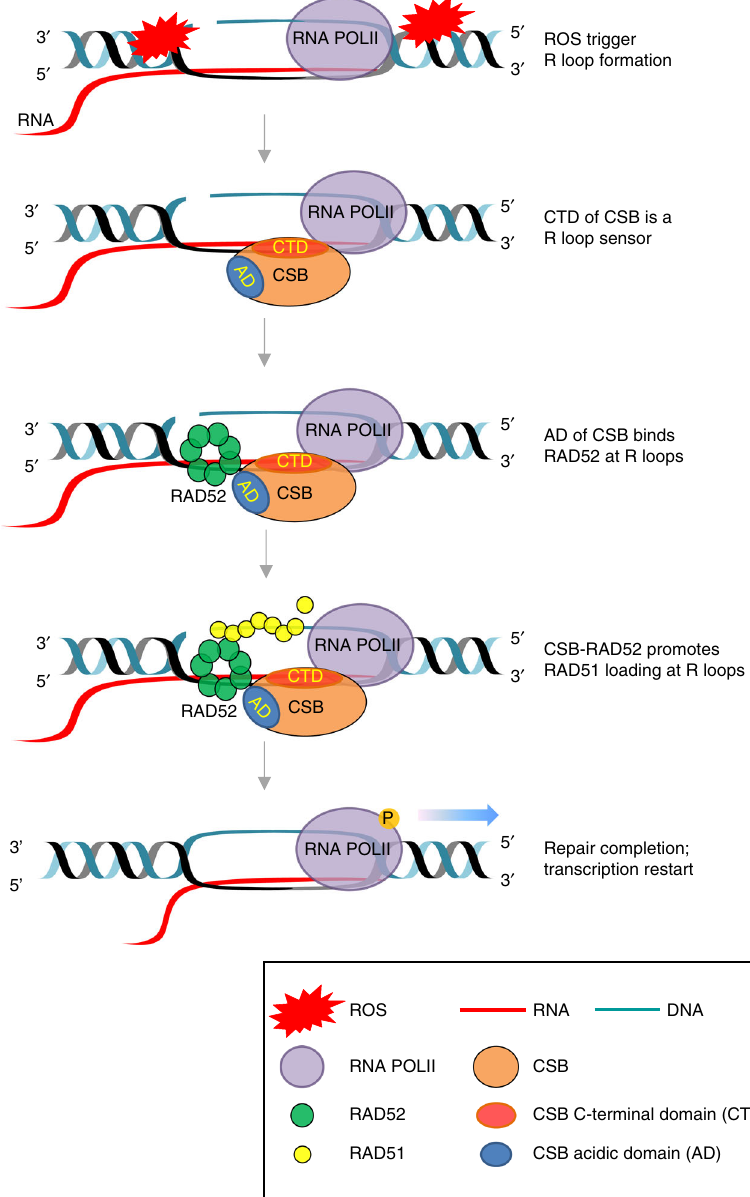
Fig. 6 Model of CSB-, RAD52-, and RAD51-mediated TC-HR at ROS-induced R loops in transcribed regions. The current model is composed of the following sequential steps: ROS at transcribed regions trigger R loop formation; CSB senses R loops via its CTD; AD of CSB binds RAD52 and facilitates RAD52 recruitment at R loops; CSB-RAD52 promotes RAD51 loading at R loops; repair completion and transcription